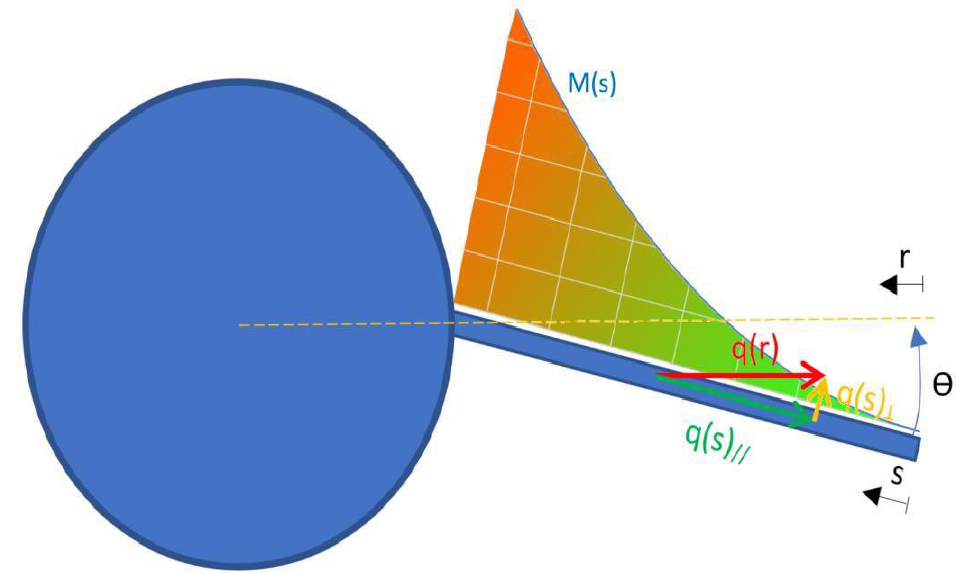
Figure 7. Simplified load and bending moment plot schematic of a prismatic leaned blade under centrifugal loads. (M(s): bending moment; q: load; r; turbine radius; s; blade span).